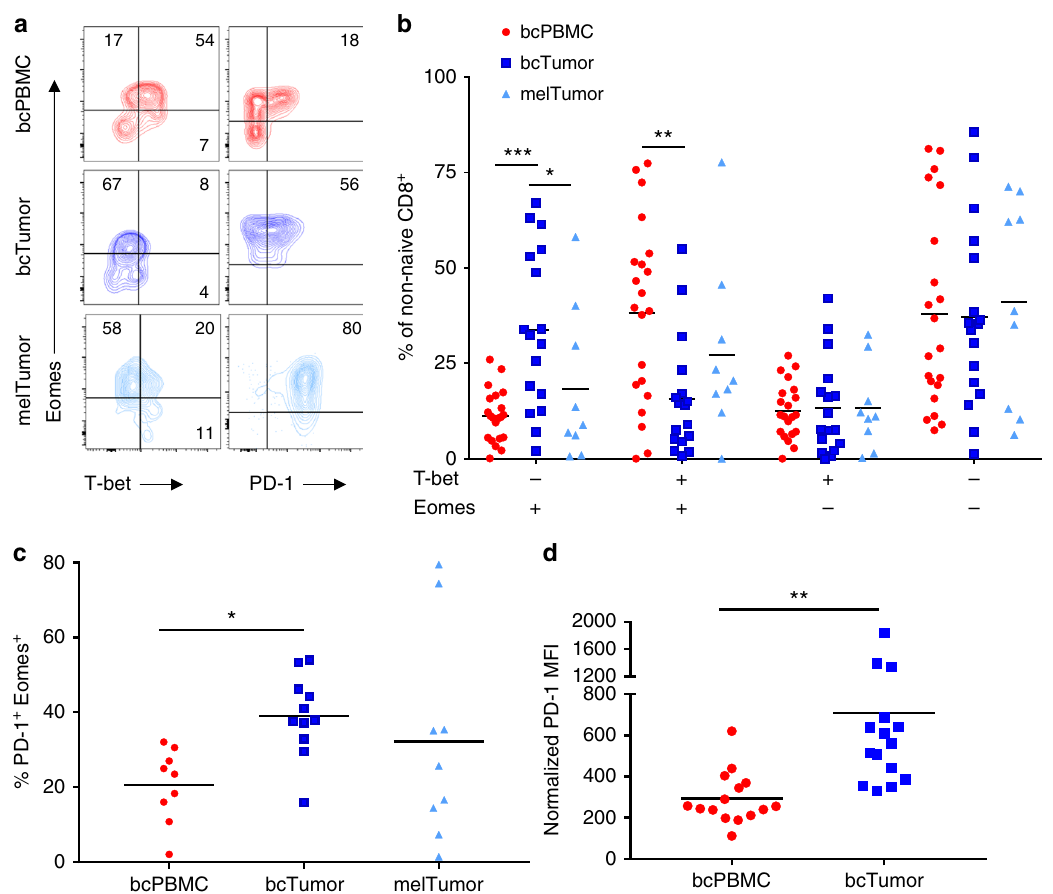
Fig. 3 CD8 + TILs in breast tumors have elevated frequencies of PD-1 + EOMES + cells. a CD8 + T cells from bcPBMCs, bcTumor, and melTumor were analyzed by fl ow cytometry for expression of T-bet, Eomes, and PD-1 as shown in representative contour plots. b Graph depicts the percentage of Eomes and T-bet expressing populations of non-naive CD8 + T cells in bcPBMCs, bcTumor, and melTumor. c Non-naive CD8 + T cells were analyzed for expression of Eomes and T-bet and gated as shown in representative contour plots. c Graph depicts the percentage of non-naive CD8 + T cells composed of PD-1 + Eomes + cells in bcPBMCs, bcTumor, and melTumor. d Normalized values of PD-1 expression on non-naive CD8 + T cells in matching bcPBMC and bcTumor samples are shown. Each symbol represents data from a unique patient sample. Signi fi cance was calculated using one-way ANOVA and Holm – Sidak multiple comparison tests b , c or an unpaired Student's t -test ( d ); * p < 0.05; ** p < 0.01; *** p <